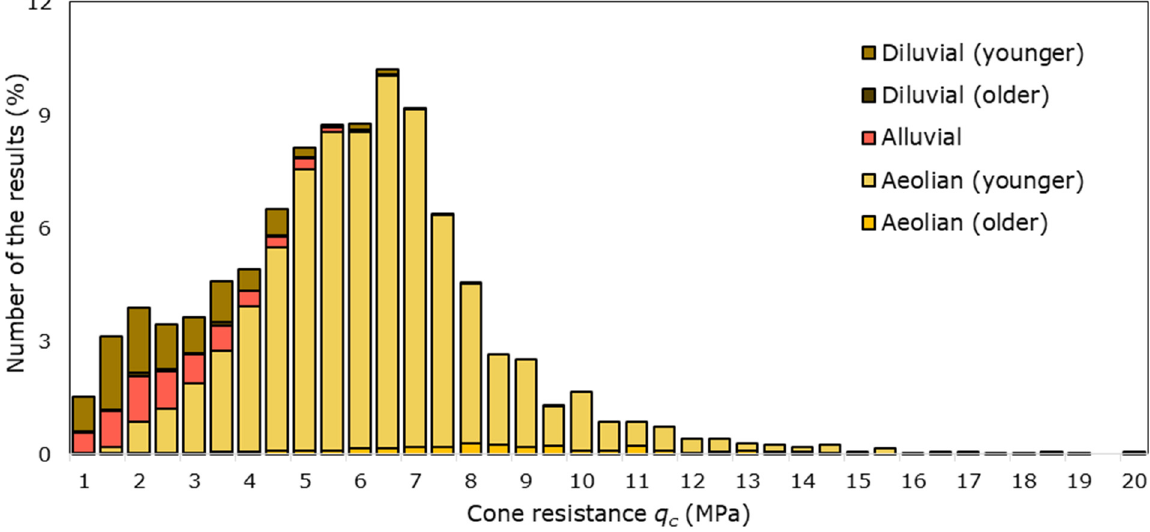
Figure 10. Distribution of q c values from CPT static soundings in the Lublin area with division into facies.